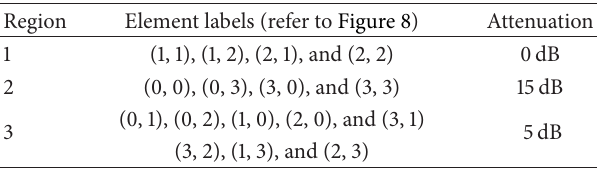
Table 1: Three regions of the antenna elements distribution on the 4 × 4 array. Region Element labels (refer to Figure